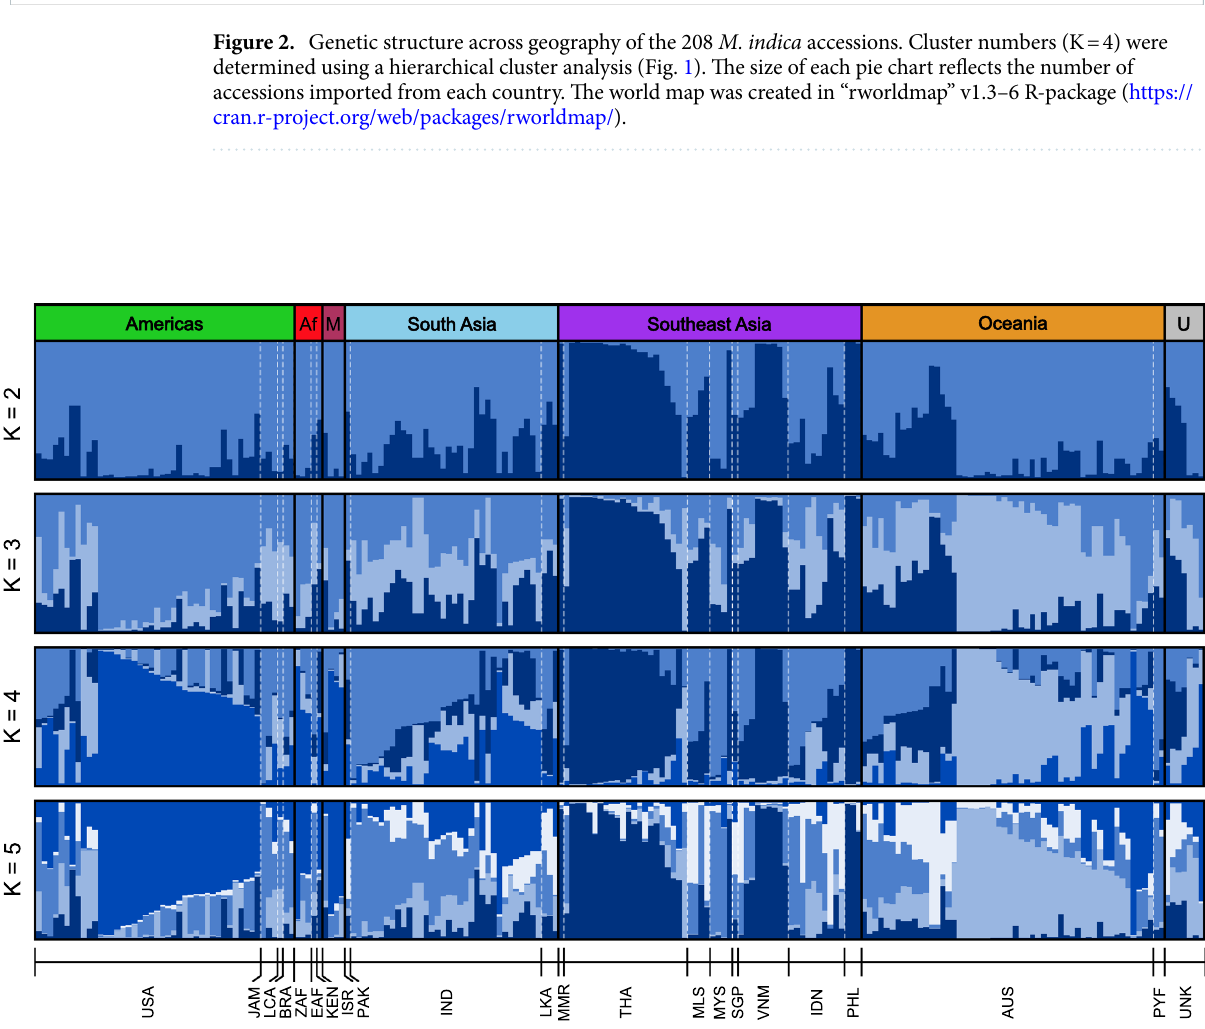
Figure 3. Genetic structure of 208 M. indica individuals using STRU CTU RE for K = 2 to K = 5. Each bar represents an individual with the shades of blue representing the ancestry proportions to each cluster. Individuals are sorted by geographical region (black lines), where Af = Africa, M = Middle East and U = unknown, and country (white dotted lines). Refer to Table 1 for information on each country